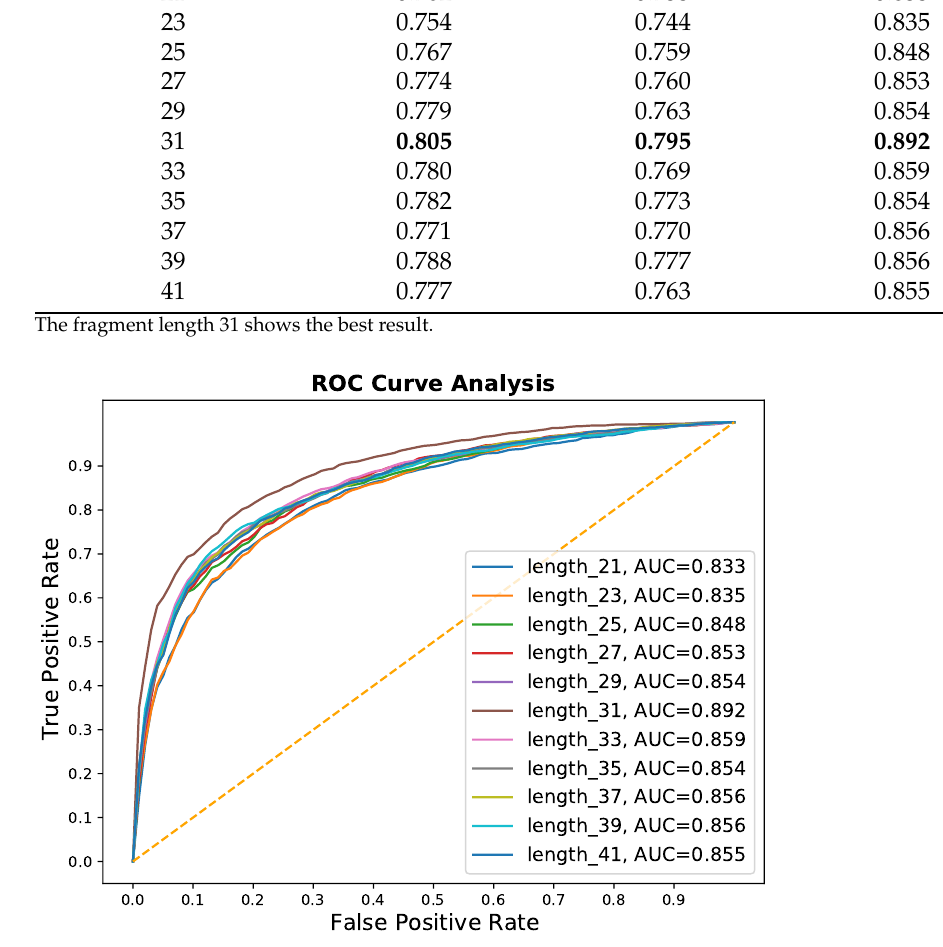
Figure 3. AUCs of different fragment